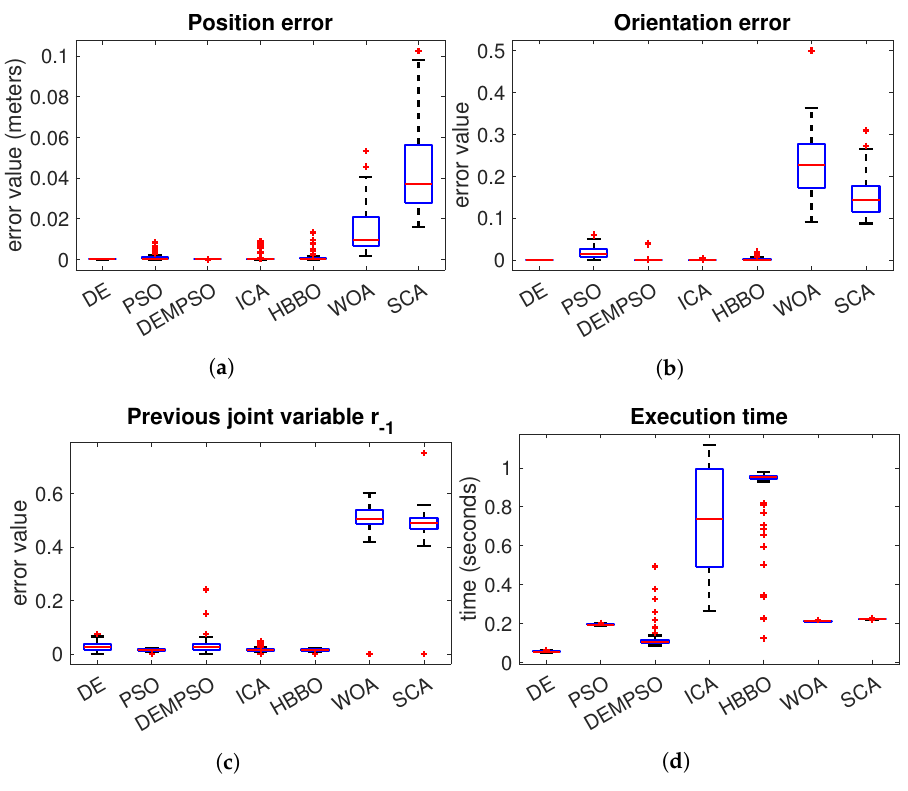
Figure 9. Lemniscate path tracking results for the Puma robot. ( a ) Puma end-effector position error (5); ( b ) Puma end-effector orientation error (15); ( c ) Puma joint variables error (16); ( d ) Execution time for each point in the